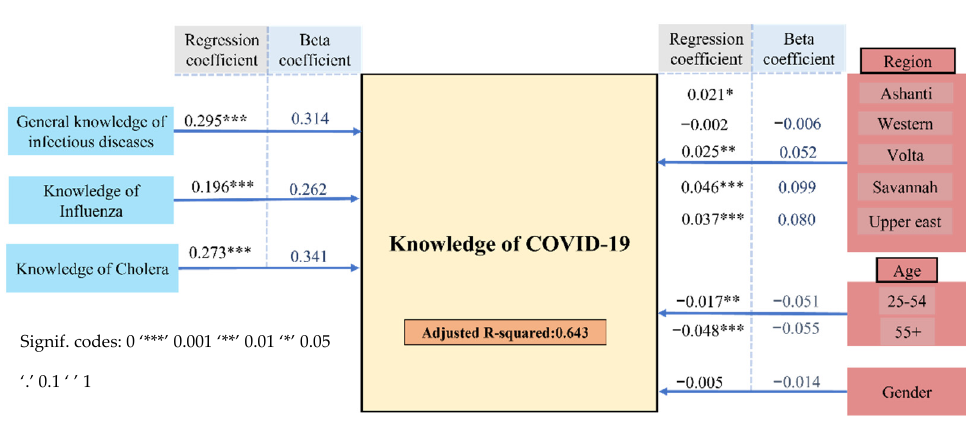
Figure 4. The extended knowledge of COVID-19 model (E-KCM) employed to assess the influences of the socio-demographic characteristics on the knowledge of COVID-19. The results are shown in terms of regression coefficient estimates and beta coefficients. The level of explained variance in the results of this model was 70.9%.